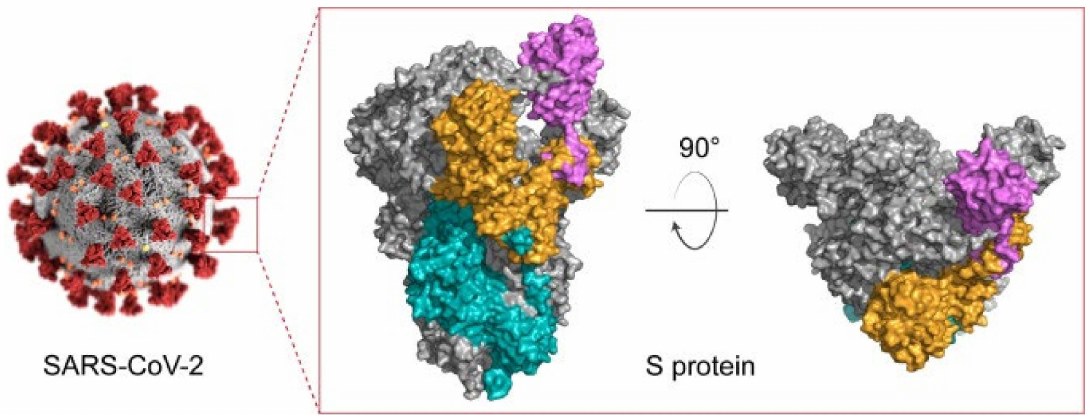
Figure 5. SARS-CoV-2 S protein consists of three identical chains with different colors of yellow that demonstrate S1 domains, and cyan that demonstrate S2 domains. Reproduced with permission from [108]. Copyright Elsevier,